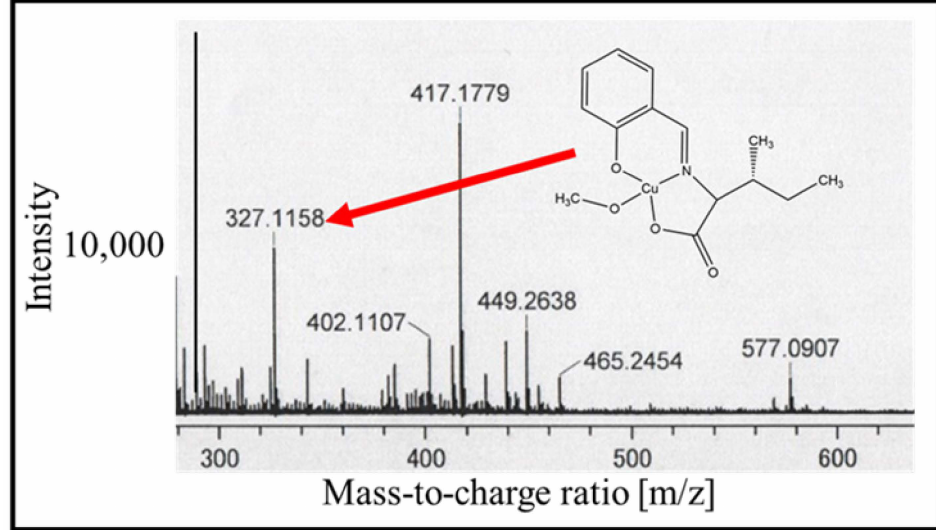
Figure 4. ESI–MS of amino acid Schiff base copper(II)